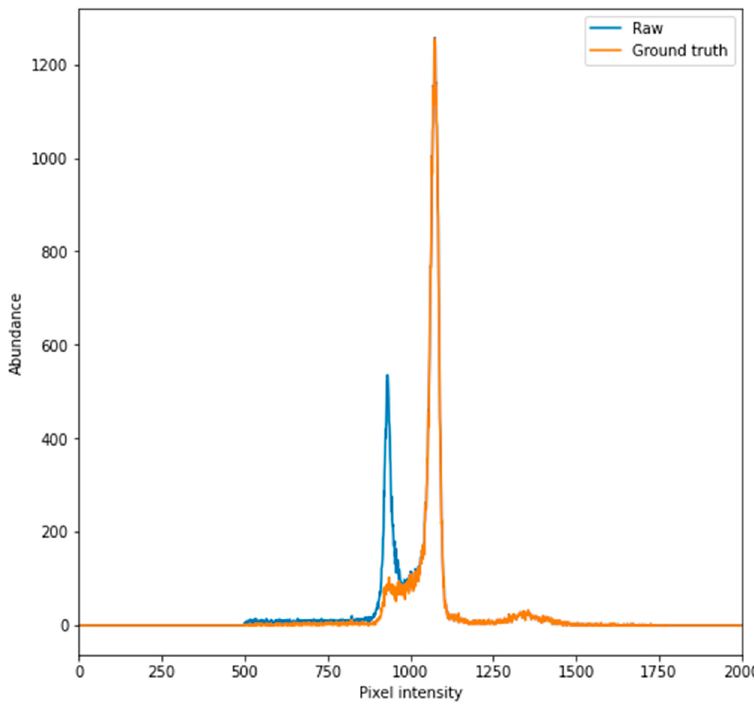
Figure 2. A representative pixel intensity histogram of raw and ground truth image shows large variance. By comparing the raw and ground truth pixel intensity histograms it can be visualised that they a) share certain areas of similarity (as seen at the peak between 1000 and 1250) but also b) contain regions which have different non-zero abundances (within the peak between 750 and 1000). As there are no regions where pixel intensity is either present or not present, images cannot be processed by simply flattening pixel intensities which lie between certain values. This type of non-linear transformation is a task in which neural networks perform well.